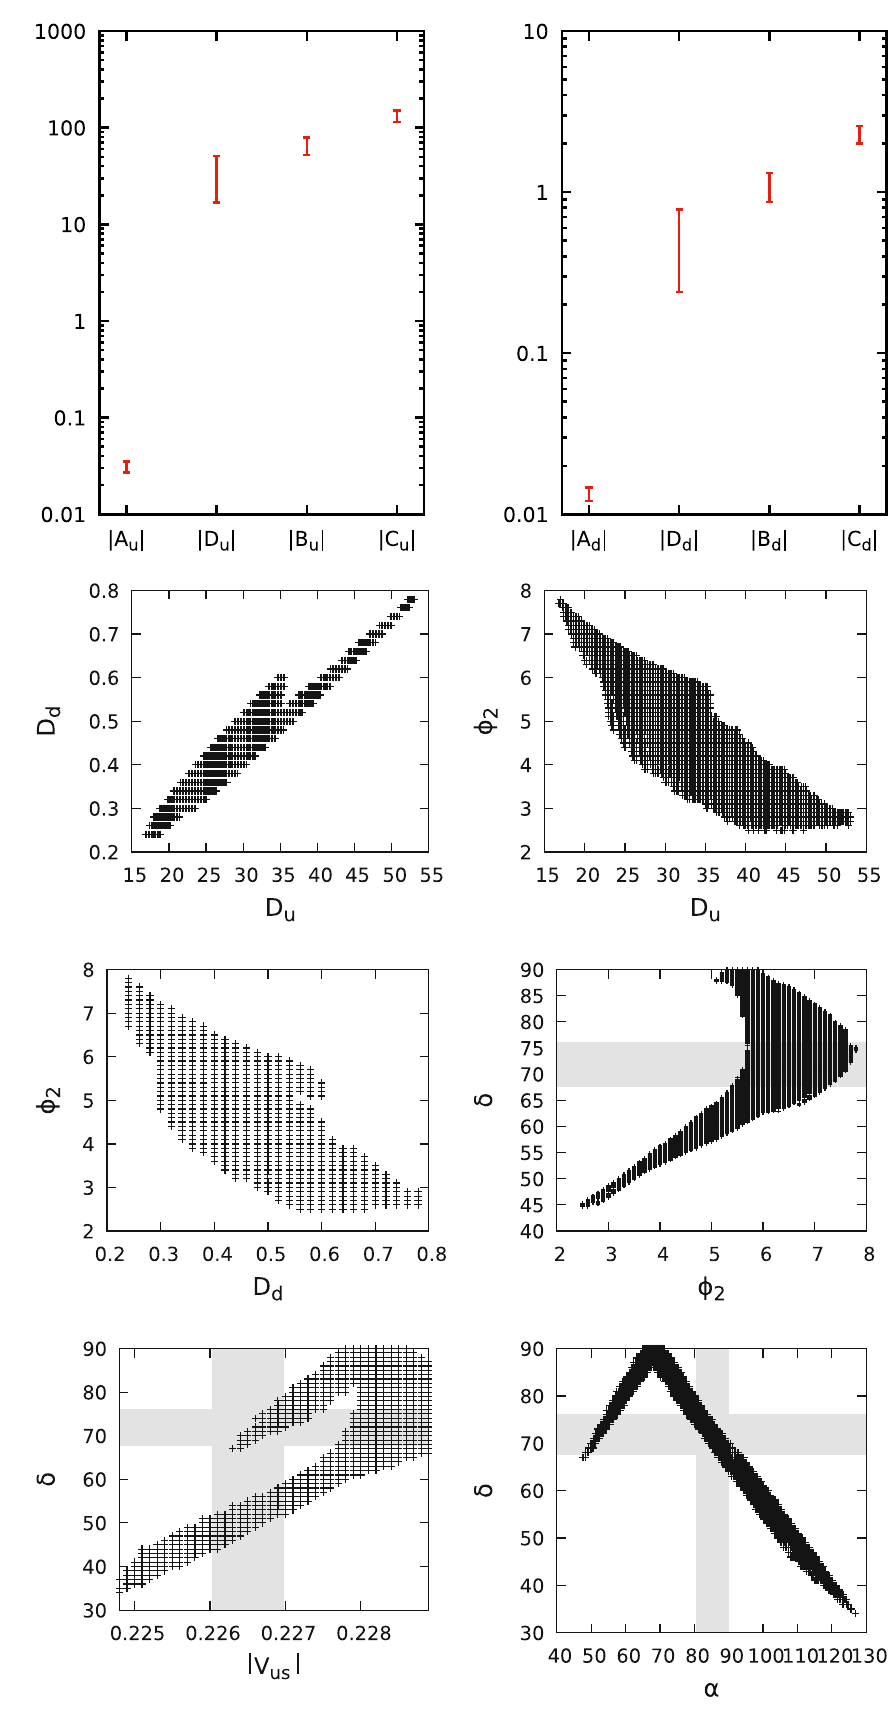
Fig. 2 The ranges of mass matrix elements for both M u and M d , depicting the hierarchy observed